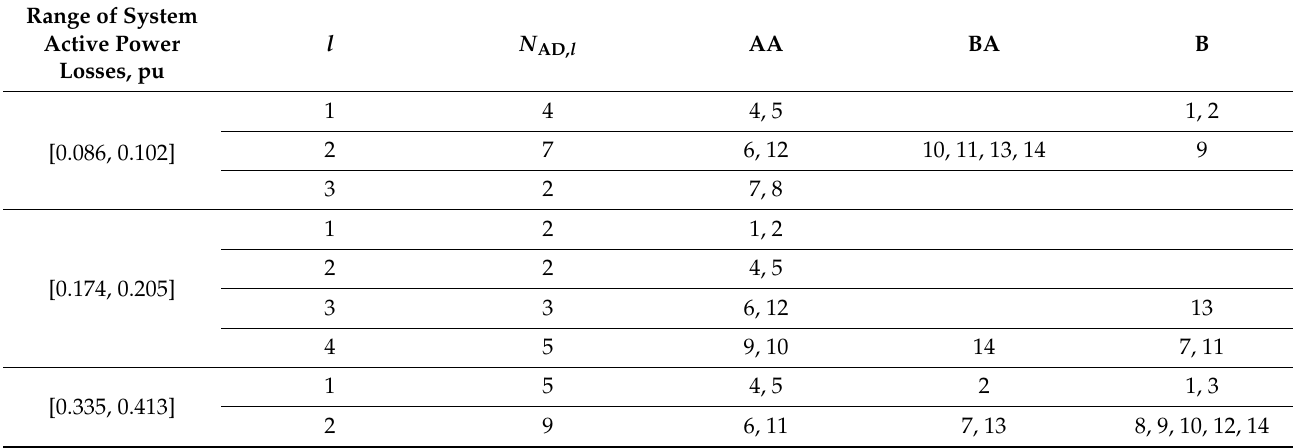
Table 8. Dominance areas in the considered power system, determined when sets S 1, S 2 , and S 3 are taken into account. Range of System Active Power Losses,